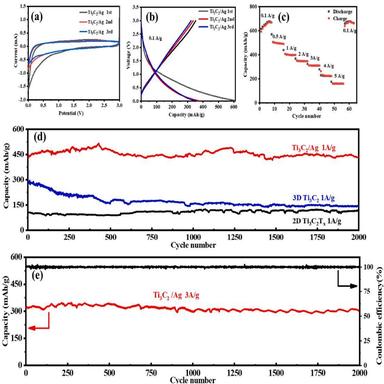
(a) Cyclic voltammetry curves of 3D Ti3C2/Ag; (b) Discharge-charge curves of 3D Ti3C2/Ag (0.1 A/g); (c) The rate performance of 3D Ti3C2/Ag; (d) Cycling performance of 2D Ti3C2Tx, 3D Ti3C2 and 3D Ti3C2/Ag (1 A/g); (e) Cycling performance of 3D Ti3C2/Ag (3 A/g).